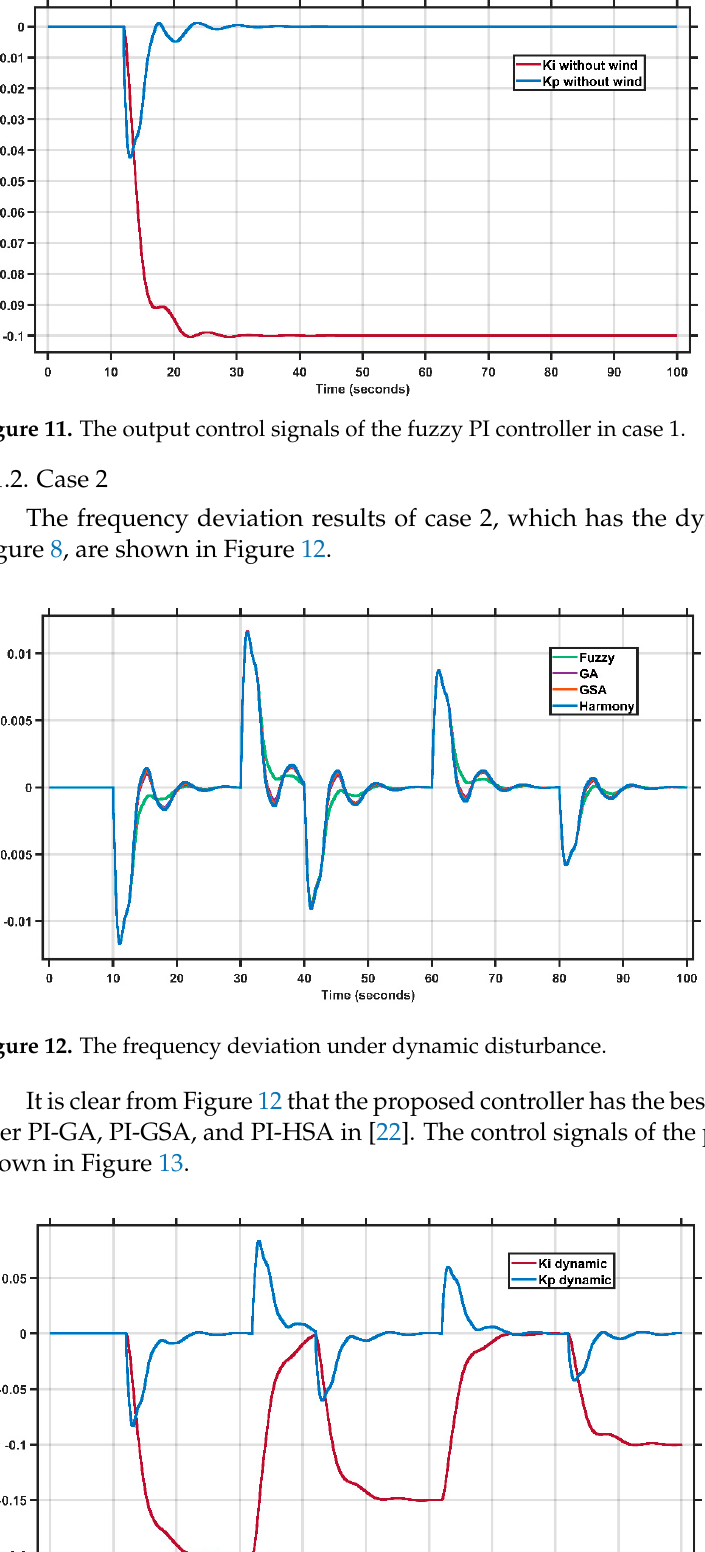
Figure 14. The frequency deviation under wind disturbance. Figure 15. The scoped frequency deviation results under wind disturbance.